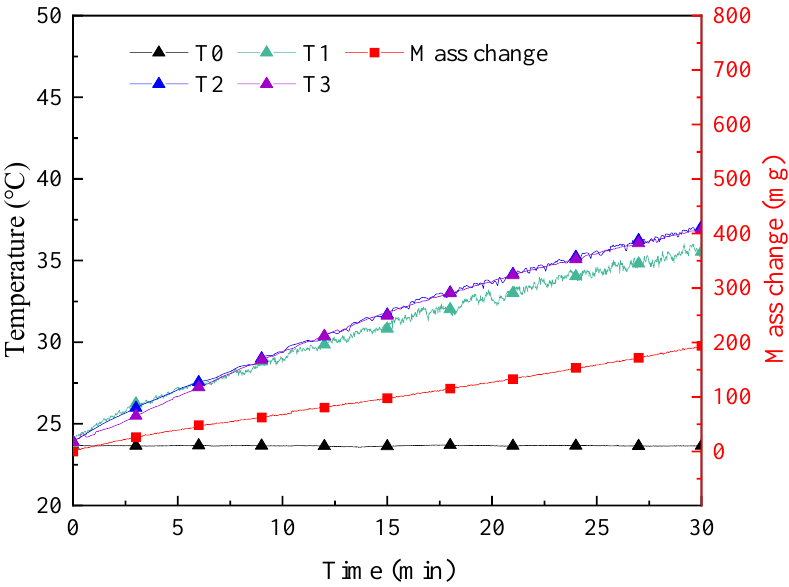
Figure 9. Curves of temperature and mass change of SiO 2 nanofluids of 1000 ppm in experiments on solar–thermal conversion characteristics.